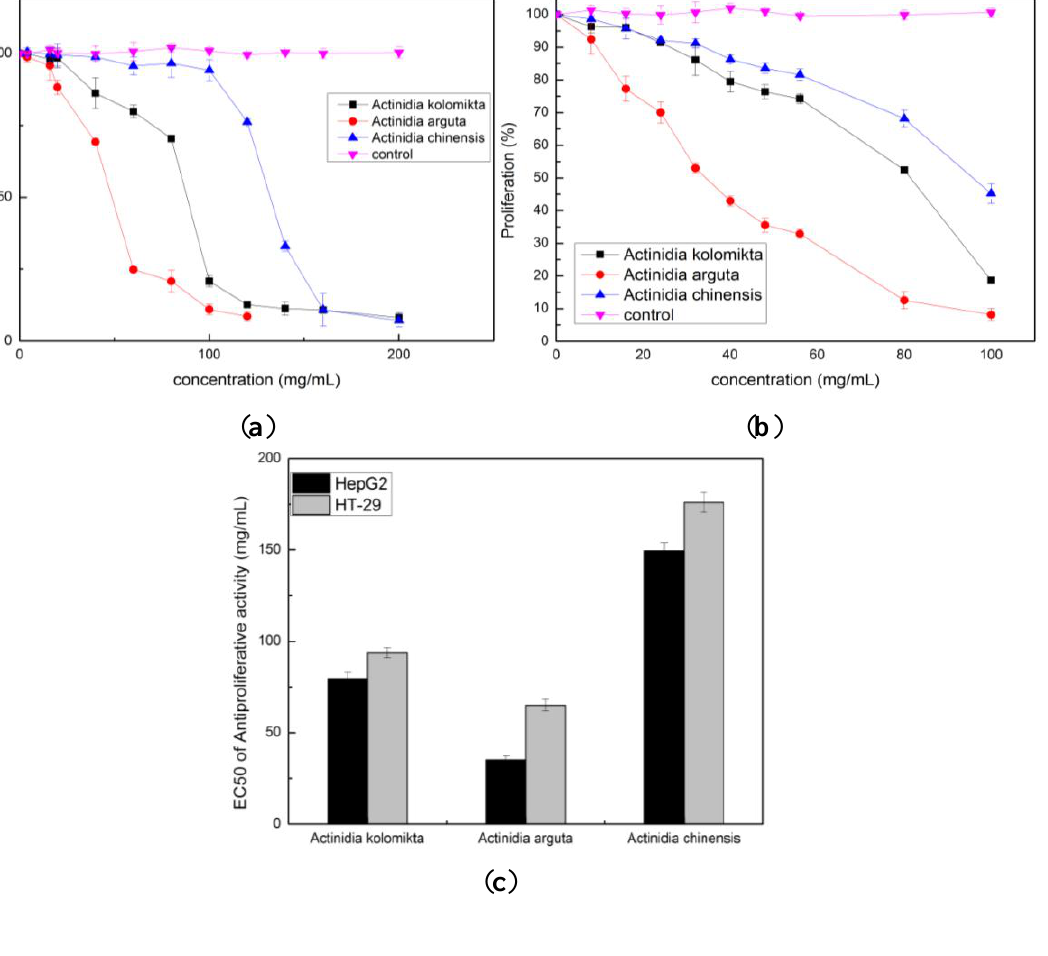
Figure 6. ( a ) Inhibition of HT-29 cell proliferation by the treatments of different concentrations of Actinidia extracts for 48 h; ( b ) Inhibition of HepG2 cell proliferation by the treatments of different concentrations of Actinidia extracts for 48 h; ( c ) EC antiproliferative activity of three Actinidia extracts on HepG2 and HT-29 (mean ± SD, n =